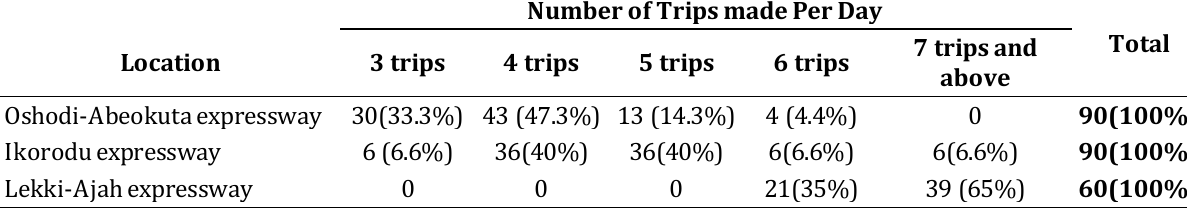
Table 4: Distribution of daily bus trips across the three highways of study